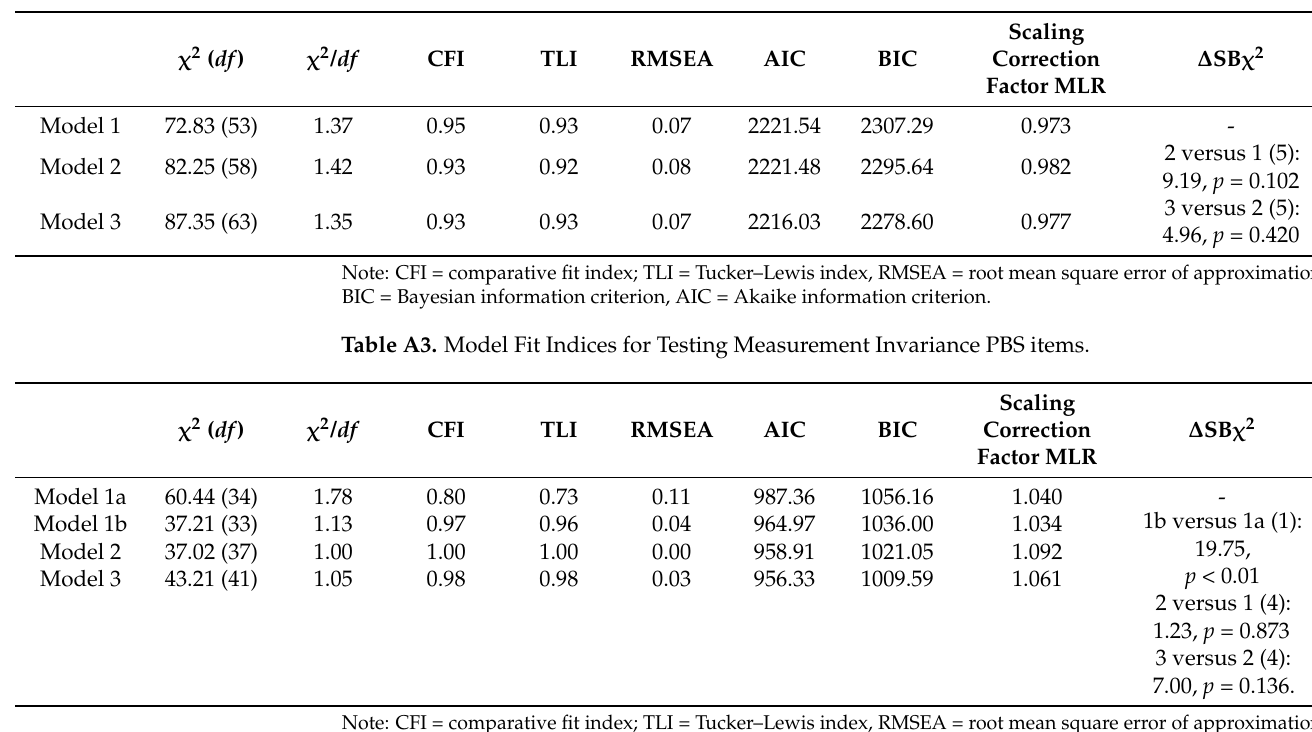
Table A2. Model Fit Indices for Testing Measurement Invariance Interview Data.